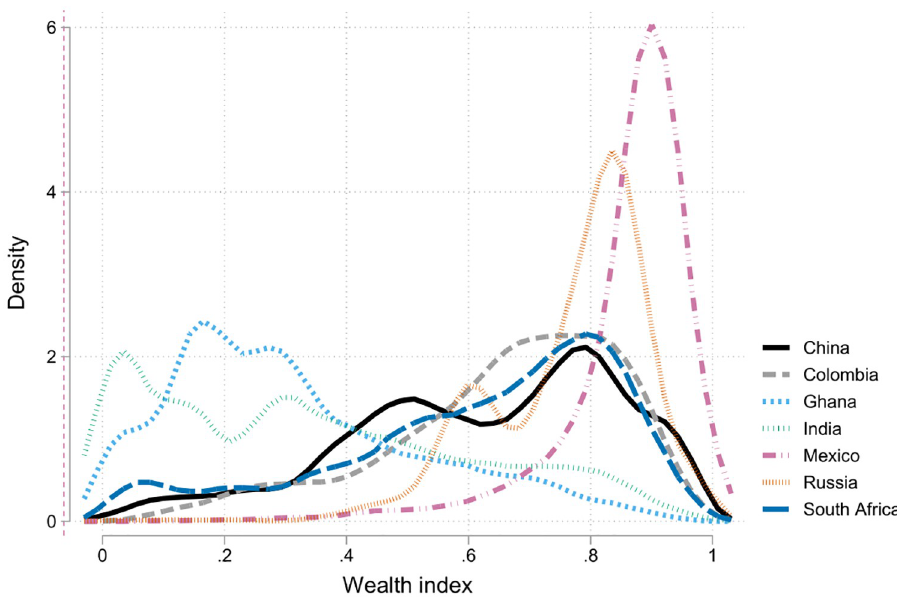
Fig 2. Densities of the wealth index by country. Notes : Epanechnikov Kernel densities using a bandwidth of 0.03 (asset index ranges from 0 to 1). Graph constructed over the sample of SABE and SAGE of respondents with a valid BP measure and a self-report of HBP. The asset index was derived using factor analysis for all individuals who answered the assets section. See online Appendix B.2 in S1 Appendix for further details.